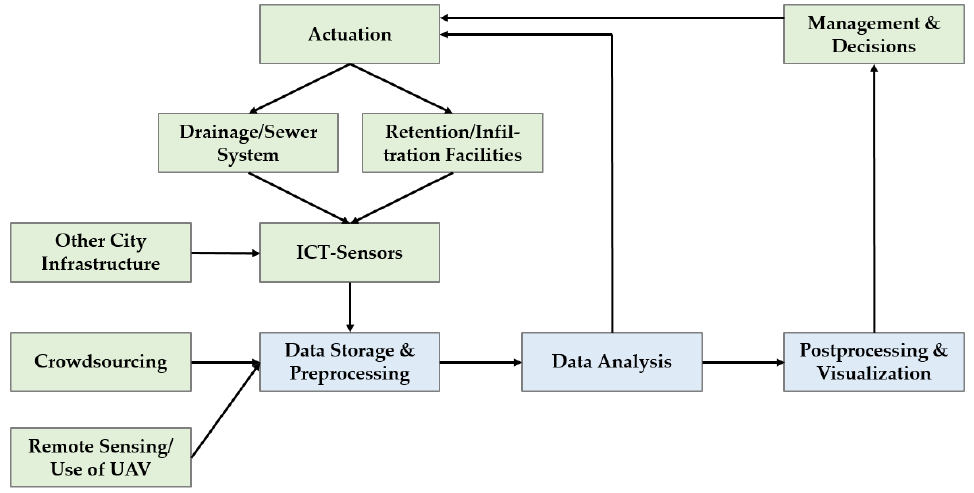
Figure 2. Detailed flow chart for smart disaster management (green: real world, blue: virtual realm).